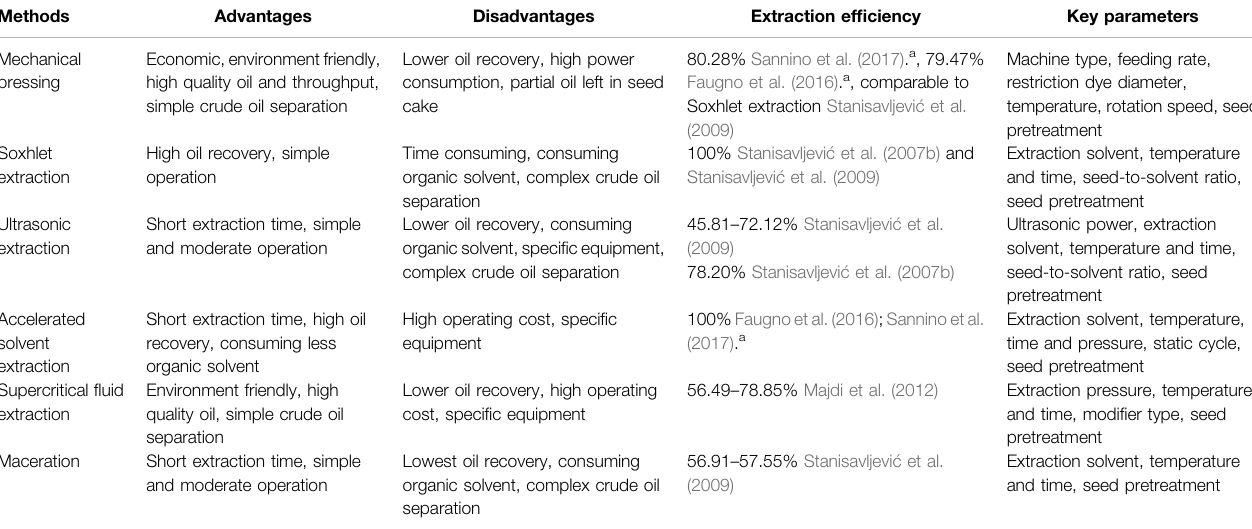
TABLE 1 | Characteristics of several common methods used in tobacco seed oil extraction.